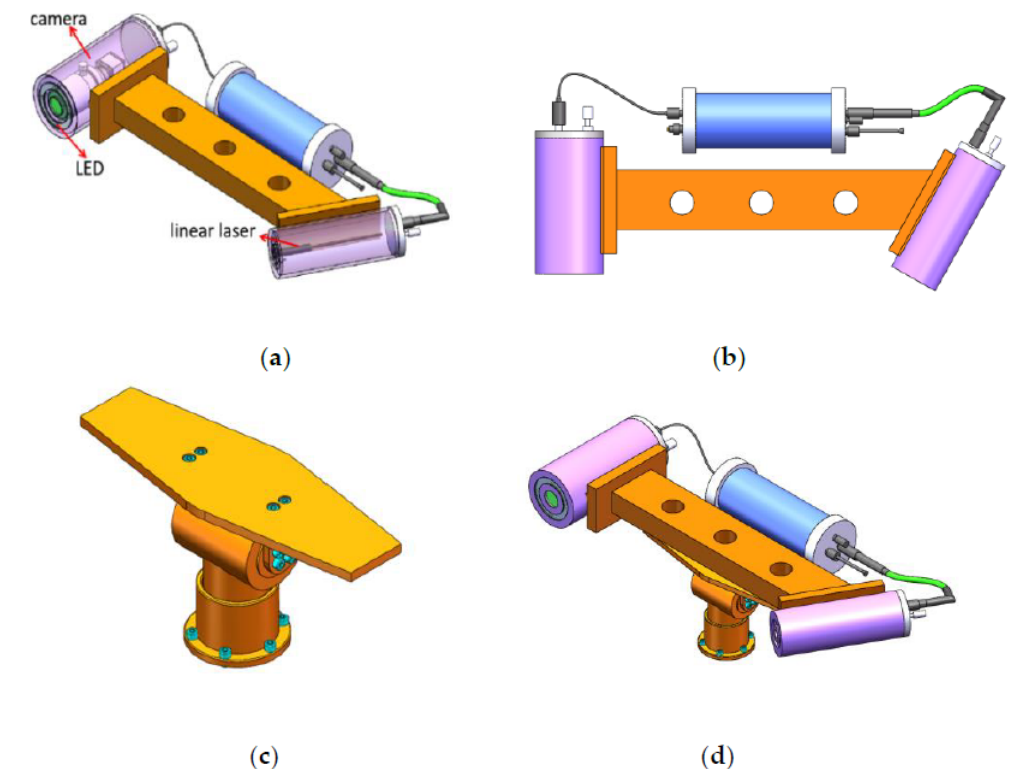
Figure 5. Mechanical model of the rotating scanning system. ( a ) Optical system; ( b ) System mechanical structure with variable included angle; ( c ) Rotating stage; ( d ) The overall model of the system.